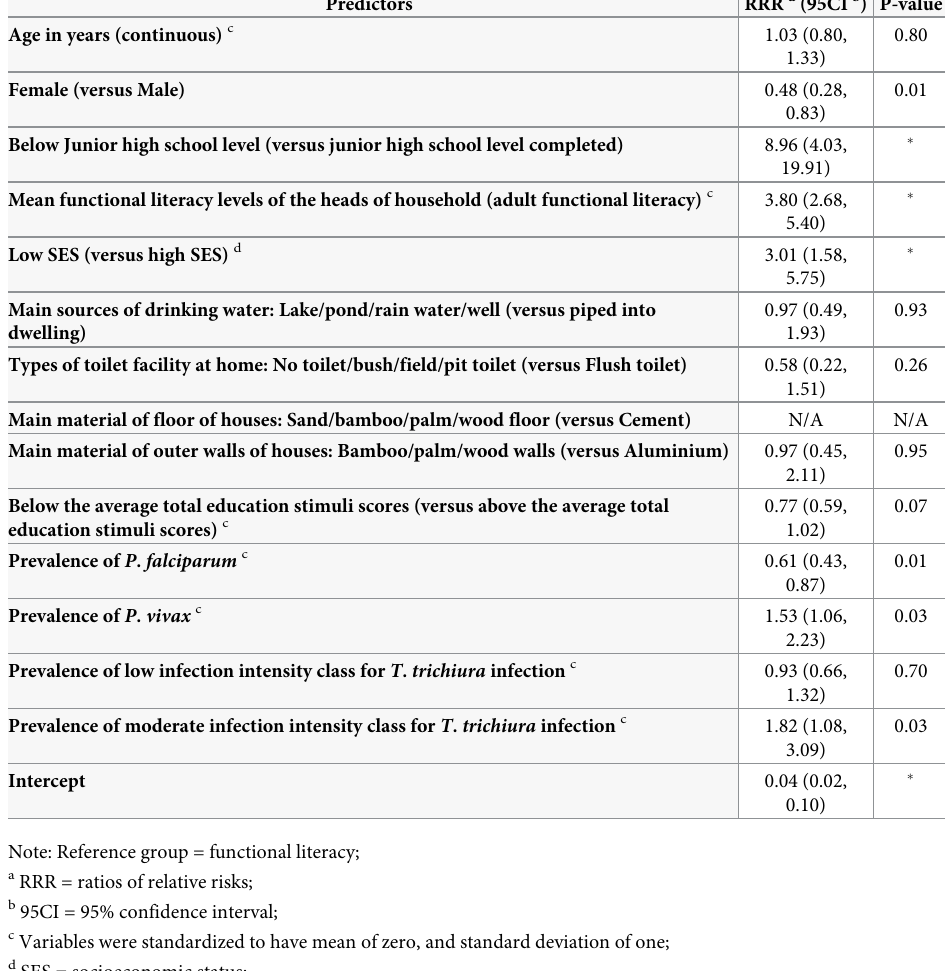
Table 7. List of predictors considered as influencing the prevalence of functional illiteracy in school-aged children in Mindanao (infection intensity classes).